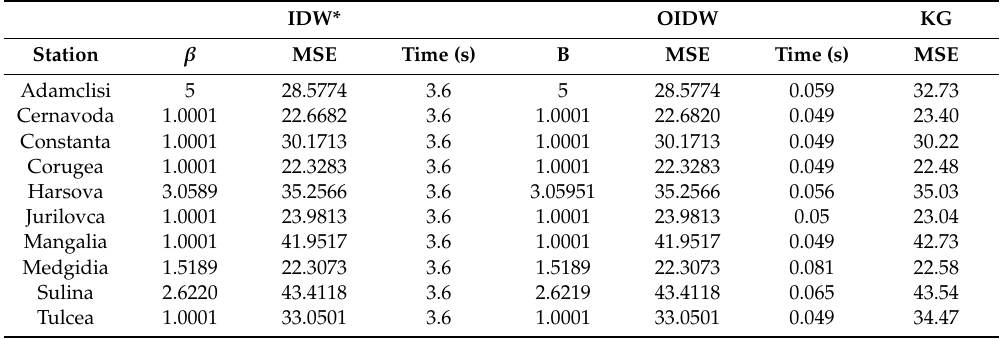
Table 2. The values of the β parameter obtained in experiments performed using the series recorded at the 10 main meteorological stations, in the scenario B1. Comparison with KG.